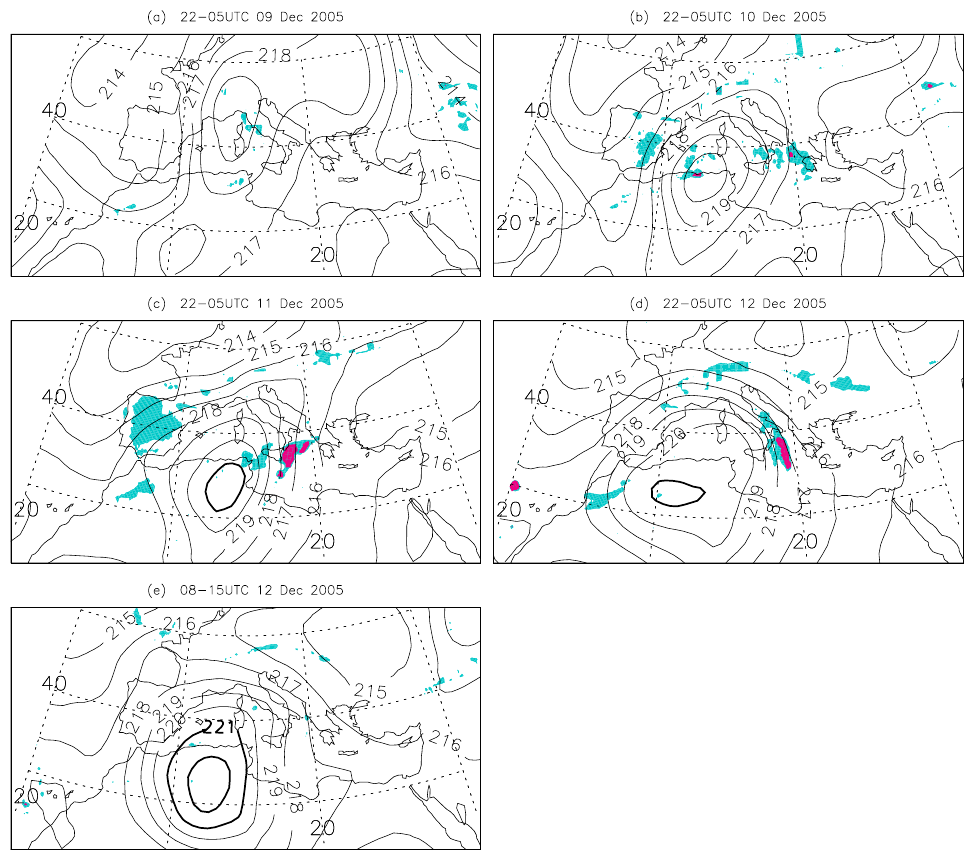
Fig. 12. Same as Fig. 4, but for 9–12 December 2005, (a–d) , descending (22:00–03:00UTC), and (e) , ascending (08:00–13:00UTC).